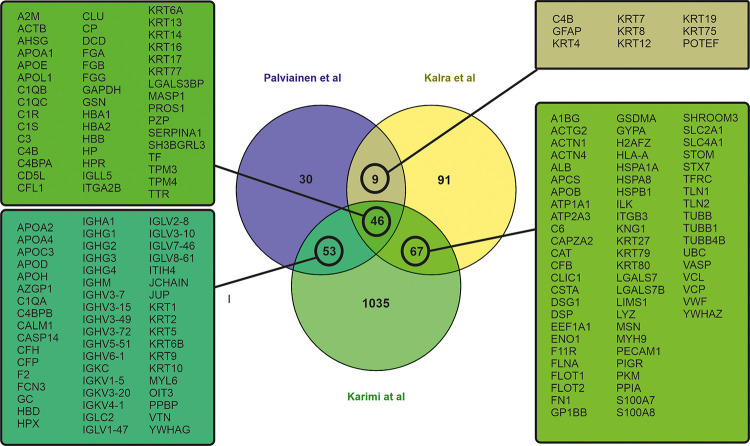
Venn diagram of overlapping proteins from a comparison of the proteomic data of our study and two previous studies of proteome of EVs [30, 36].